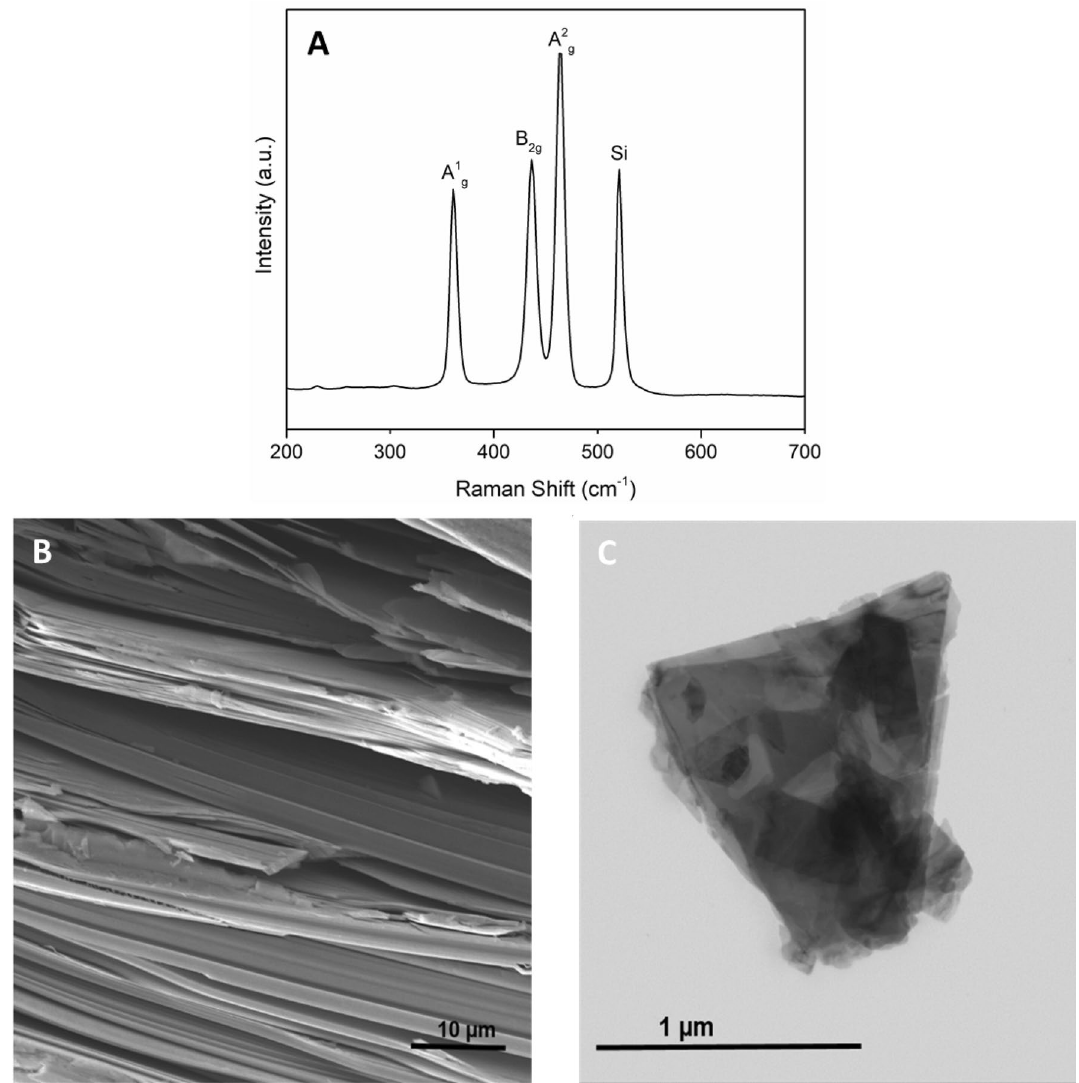
Figure 1. ( A ) Raman spectrum of 2D BP; ( B ) SEM image of BP microcrystals, scale bar: 10 µm; ( C ) Bright field STEM image of exfoliated BP nanosheets, scale bar: 1